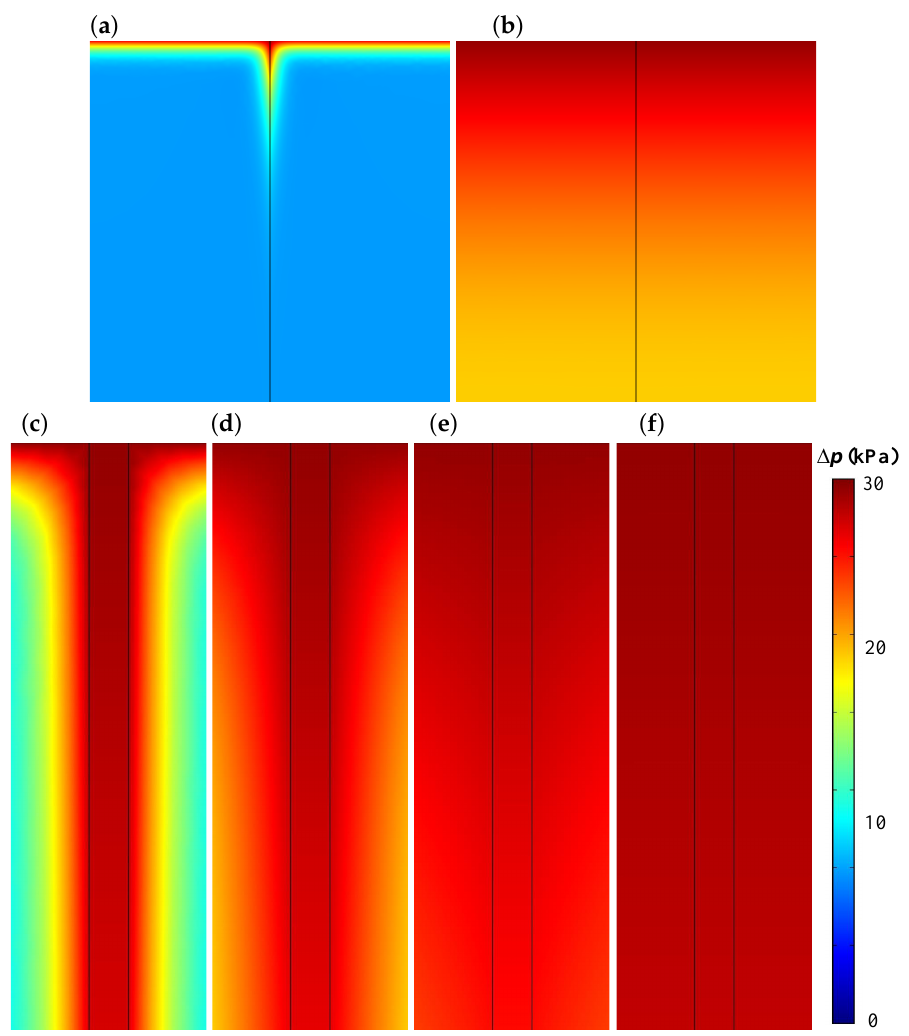
Figure 8. Influence of the host rock matrix permeability on the pore pressure after 63 hours (high tide). Panels ( a ) and ( b ) show a general view (5 km by 5 km) of two models. Panels ( c – f ) show a close-up view (50 m by 150 m) of the upper part of the fault. The permeability of the host rock ranges from k = 10 − 15 to k = 10 − 10 m 2 and the permeability of the fault is set to k F = 10 − 10 m 2 . The remaining hydro-mechanical properties are listed in Table 2. The Young modulus of the host rock and the fault is 40 GPa and the Biot coefficient is 0.8. ( a ) k / k F = 10 − 3 , ( b ) k / k F = 1, ( c ) k / k F = 10 − 5 , ( d ) k / k F = 10 − 4 , ( e ) k / k F = 10 − 3 , ( f ) k / k F =